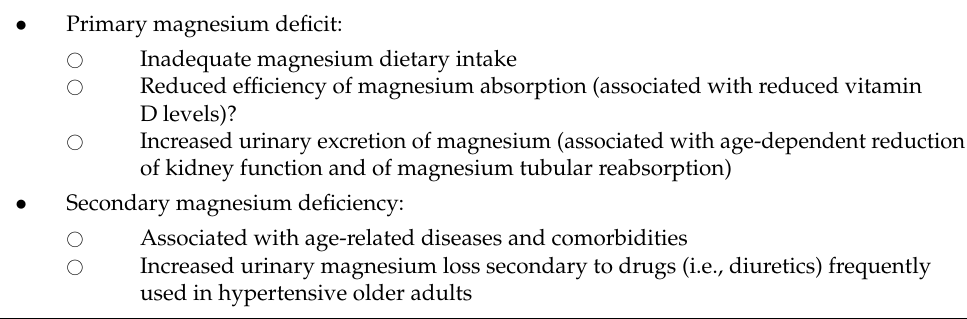
Table 3. Main Mechanisms of Magnesium Deficit with